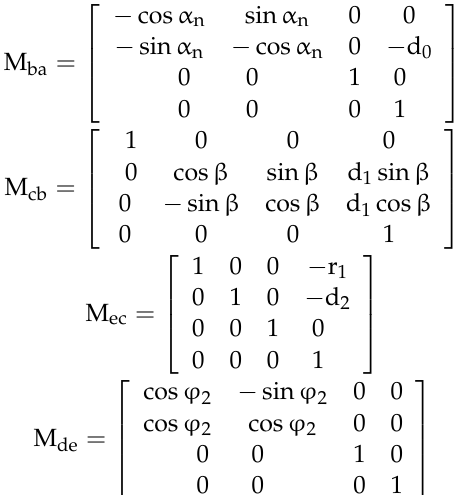
Figure 6. Rack projection.